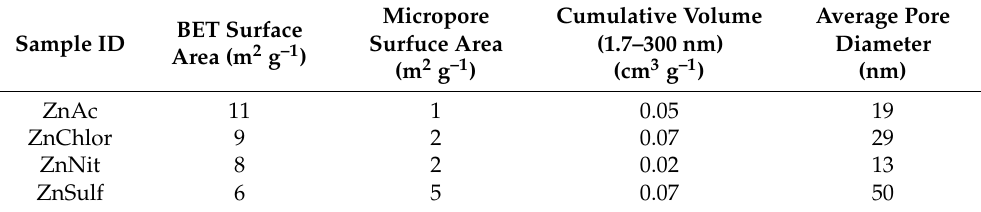
Table 6. Results of the BET method. (a) Micropore surface area via t-plot analysis, according to the Harkins and Jura model. (b) Cumulative volume of pores between 1.7 and 300 nm from N2-sorption data and the BJH desorption method. (c) Average pore diameter, calculated by the 4 V/ σ method; V was set equal to the maximum volume of N2 adsorbed along the isotherm as P/Po → 1.0.